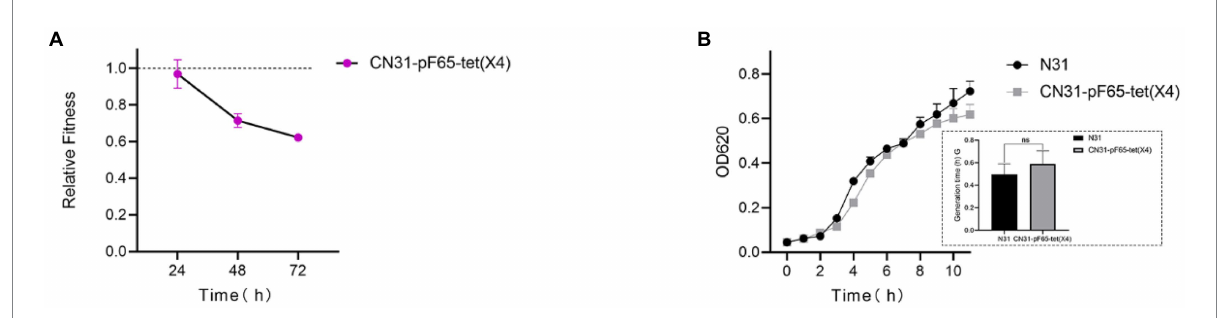
FIGURE 1 tet (X4)-positive plasmid imposes fitness cost on E. coli N31. (A) Relative fitness of tet (X4)-positive plasmid-carrying strains versus isogenic plasmid- free strains in vitro . (B) Comparison of growth curve and generation time (lower right corner) between tet (X4)-positive plasmid-carrying and plasmid-free strains.